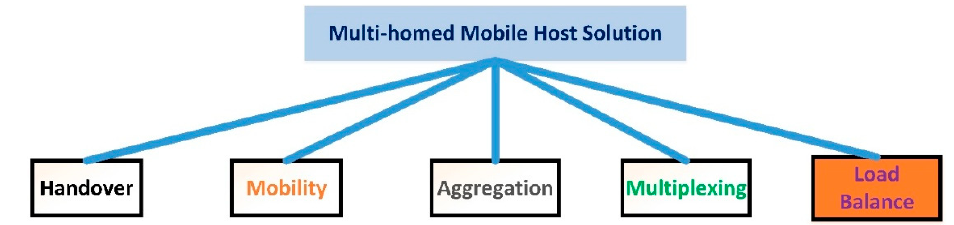
Figure 1. Multi-homed host Figure 1. Multi ‐ homed host solutions.